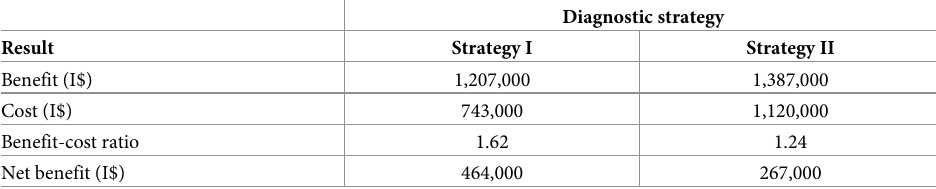
Table 3. Results of costs and benefits from Strategy I and Strategy II under base-case